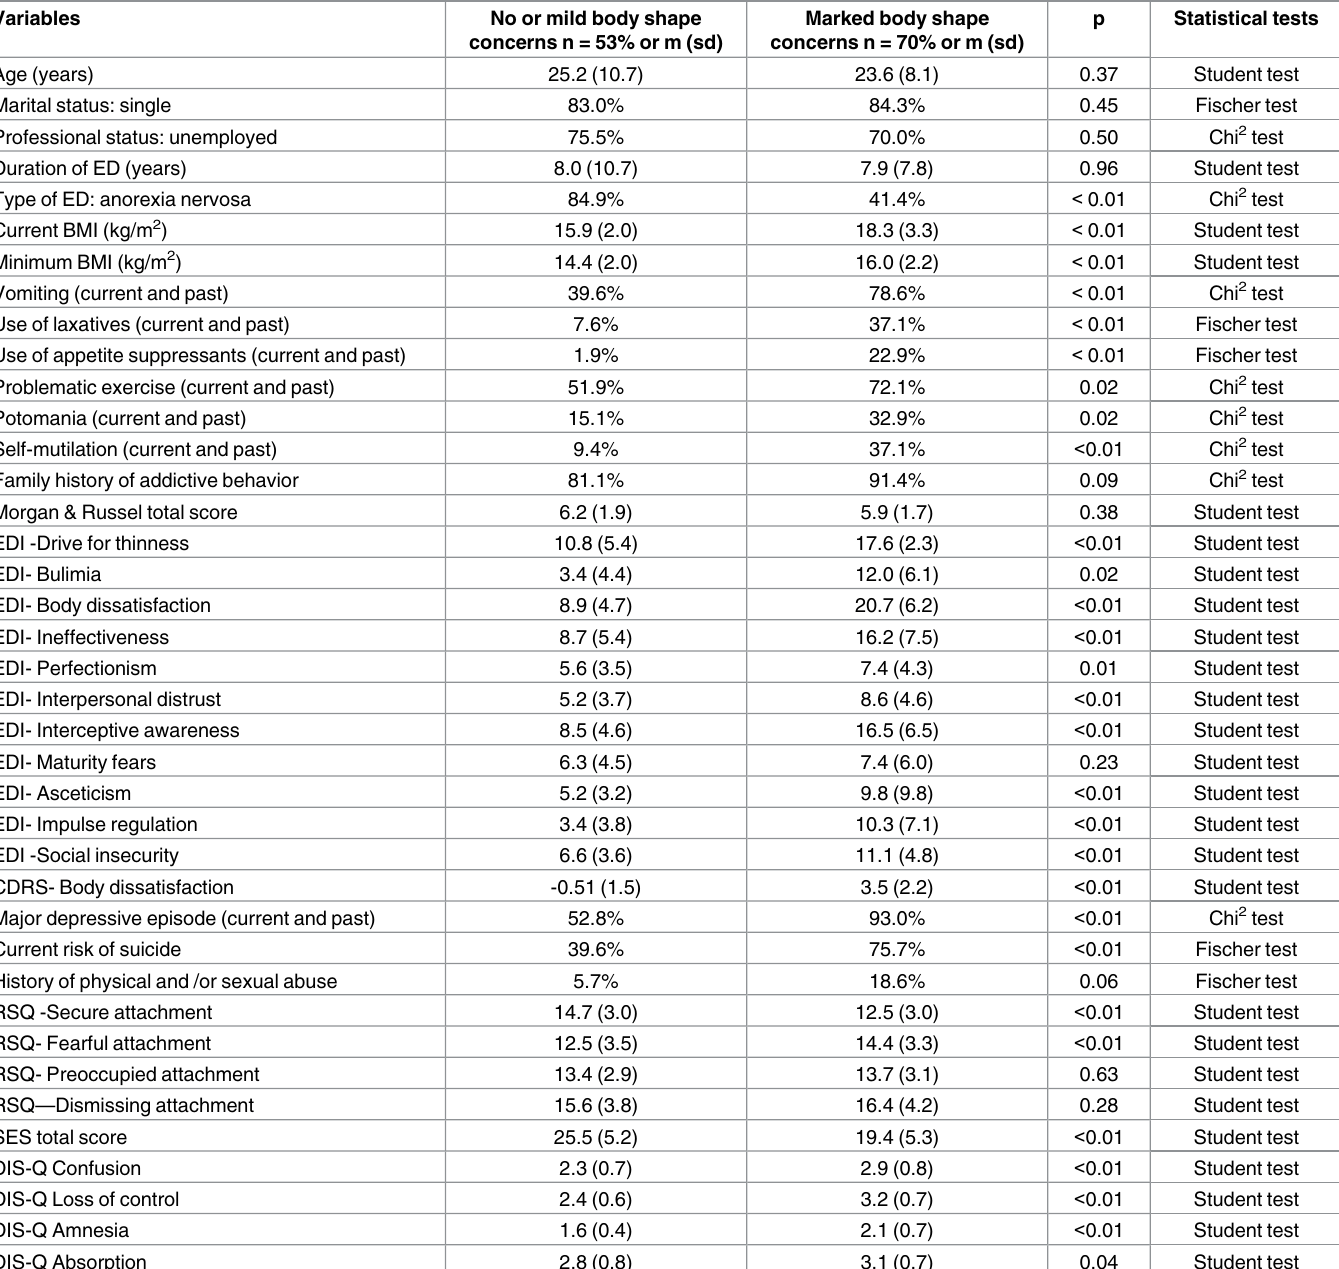
Table 3. Univariate comparison of patients according to the intensity of body shape concerns (N =